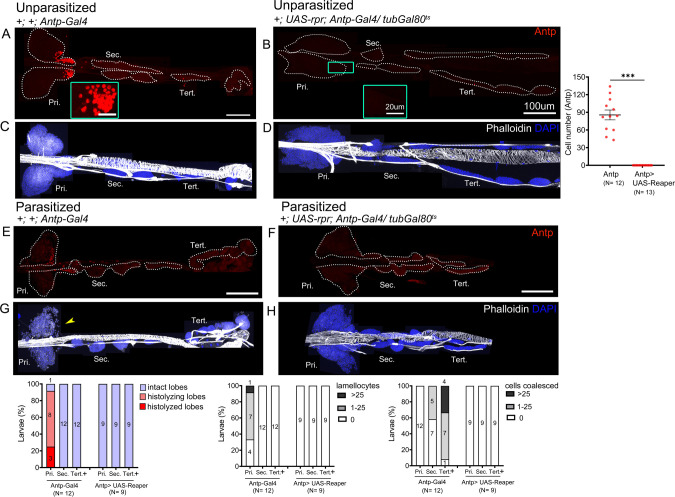
Posterior signaling center (PSC)-less lymph glands do not differentiate in response to wasp parasitism.(A–D) Unparasitized and (E–H) parasitized lymph glands analyzed 4 days post-parasitism. Antennapedia (red) is expressed in the PSC (A and E) and is absent in PSC-ablated lymph glands (B and F). (A and B) Green inset shows PSC and graph shows quantification for Antp+ cells in PSC ablated larvae as compared to controls in unparasitized conditions. Mann–Whitney nonparametric test was used for statistical analysis. (H) PSC-ablated lymph glands do not form lamellocytes and cell coalescence is inhibited in response to wasp parasitism as compared to parasitized control lymph glands (G). For quantifications, nuclei of cells showing lamellocyte morphology (phalloidin) (white) were manually counted. Graphs indicate quantification for the cellular phenotypes: premature histolysis of lymph gland lobes, lamellocyte induction, or compromised cell boundaries. Yellow arrowheads indicate histolyzing lobes. Pri. indicates primary lobes, Sec. indicates secondary lobes, and Tert. indicates tertiary lobes. ***p<0.001. (A–H) Scale bar: 100 µm or 20 µm in inset.Figure 4—figure supplement 2—source data 1.Numerical data plotted and statistical analysis related to Figure 4—figure supplement 2.